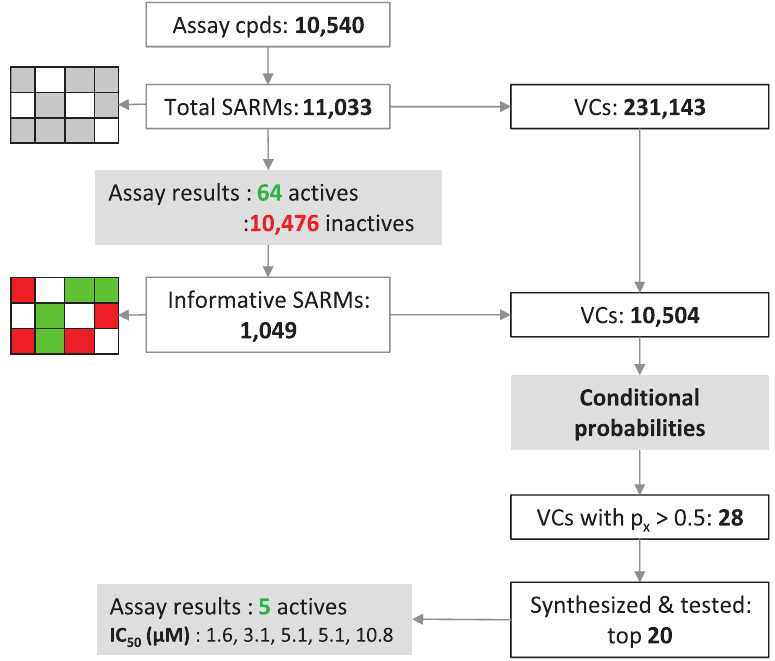
Figure 4. SAR matrix and prediction statistics. SAR matrix statistics for a library of alpha helical turn mimetics are provided and activity predictions for virtual compounds are summarized. For these predictions, conditional probabilities of activity were derived from library screening